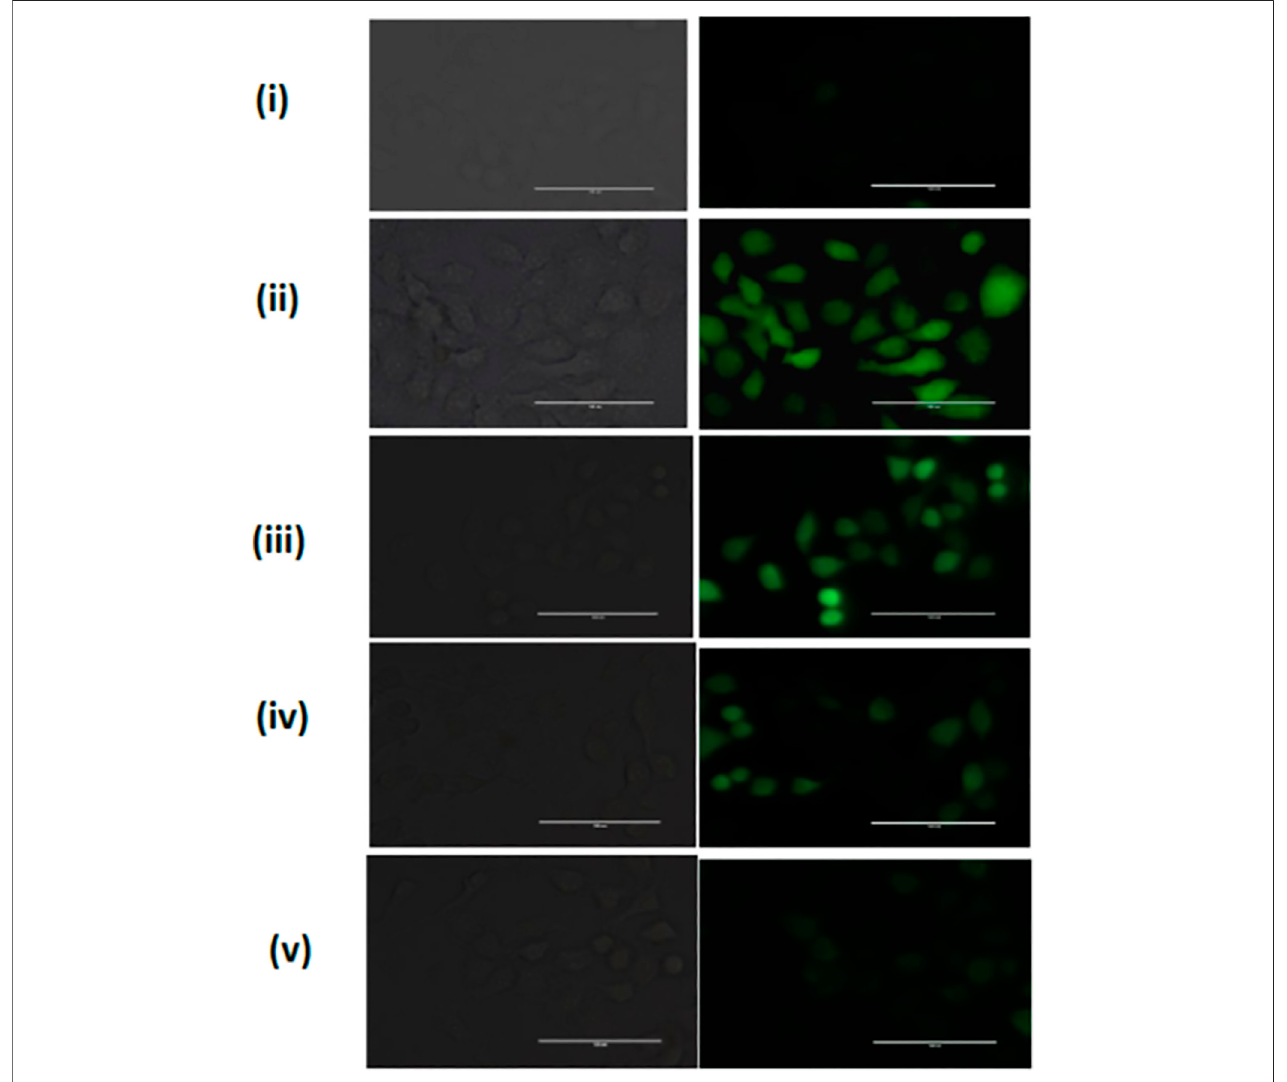
FIGURE 6 | The ROS scavenging in L-132 cells. A Representative fl uorescence image was acquired for H 2 O 2 -treated L-132 cells after DCFH-DA dye staining (i) Untreated cells, (ii) H 2 O 2 treated cells without HSA-PEI-SF-pSOD1 Np ’ spreincubation, and (iii – v)H 2 O 2 treated cells withan increase inHSA-PEI-SF-pSOD1 Np ’ s at 12, 24, and 96 h preincubation time. All the scale bars represent 100